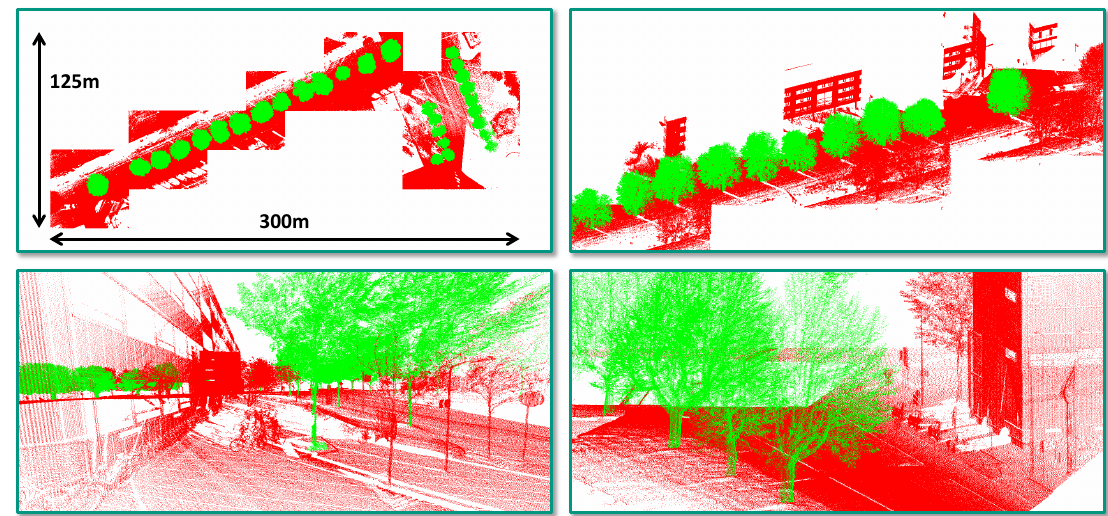
Figure 4. Visualization of the IQPC’15 benchmark dataset with about 10.13 M labeled 3D points ( top : nadir view and side view; bottom : more detailed views): those 3D points categorized as “tree points” are colored in green, and those 3D points categorized as “other points” are colored in red